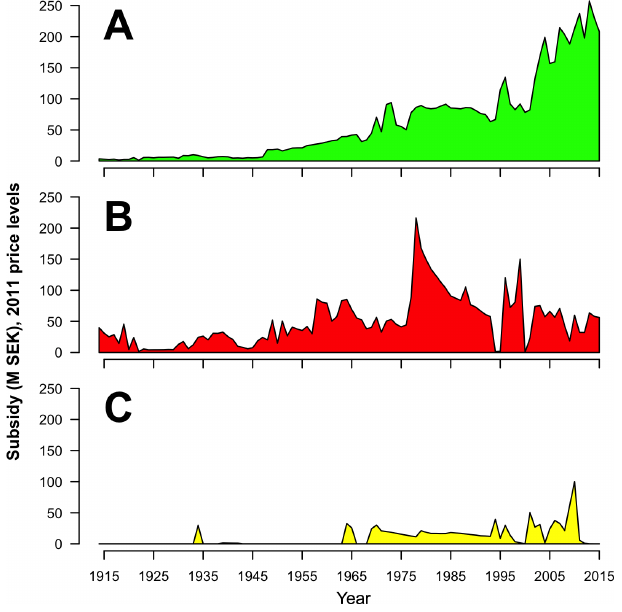
Fig. 2 . Change in governmental spending on fisheries (A: beneficial, B: capacity-enhancing subsidies, and C: ambiguous) toward fisheries (1914–2015). M SEK = millions, Swedish Krona.